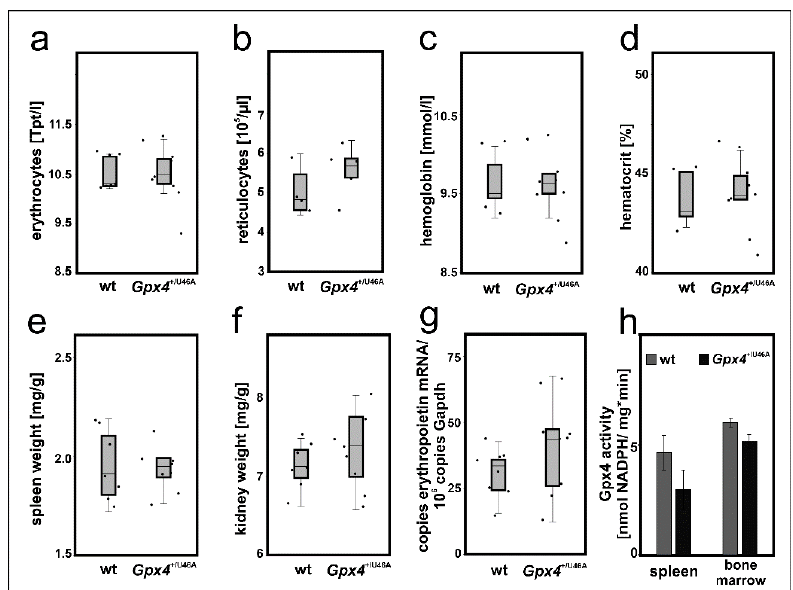
Figure 7. Heterozygous expression of catalytically inactive Gpx4 in mice does not induce a defective erythropoietic phenotype. 200 µL blood was withdrawn from male Sec46Ala Gpx4 mutant ( Gpx4 +/U46A ) and corresponding wild type (wt) mice. For blood removal mice were sacrificed by cervical dislocation after isoflurane anesthesia and blood was collected by cardiac puncture. Coagulation was inhibited by EDTA and the basic red blood cell parameters were determined as described in Material and Methods. ( a ) erythrocyte count, ( b ) reticulocyte counts, ( c ) hemoglobin, ( d ) hematocrit. n = 5–8 animals were analyzed. The wet weights of spleens and kidneys of male Sec46Ala Gpx4 mutant ( Gpx4 +/U46A ) and corresponding wild type (wt) mice were determined and the bodyweight/organ weight ratios were calculated. ( e ) spleen/body weight ratios, ( f ) and kidney/body weight ratios. n = 7–8 animals were analyzed. ( g ) Renal expression of erythropoietin (Epo) mRNA. Total RNA was extracted from kidneys of wild type (wt) and Sec46Ala Gpx4 mutant ( Gpx4 +/U46A ) mice. Epo mRNA expression levels were quantified by qRT-PCR (see “Material and Methods”). For these experiments, n = 8 animals were sacrificed and each sample was quantified in triplicate. Significances were calculated using the Mann-Whitney U test and p -values < 0.05 were considered statistically significant. ( h ) Gpx4 activity assays. Spleen and bone marrow cells were homogenized, the 10,000 g lysate supernatant was prepared and the Gpx4 activity was assayed using RP-HPLC purified phosphadidylcholine hydroperoxide as substrate. Significances were calculated using the Student’s t -test. Two animals of each genotype were used and each sample was quantified in